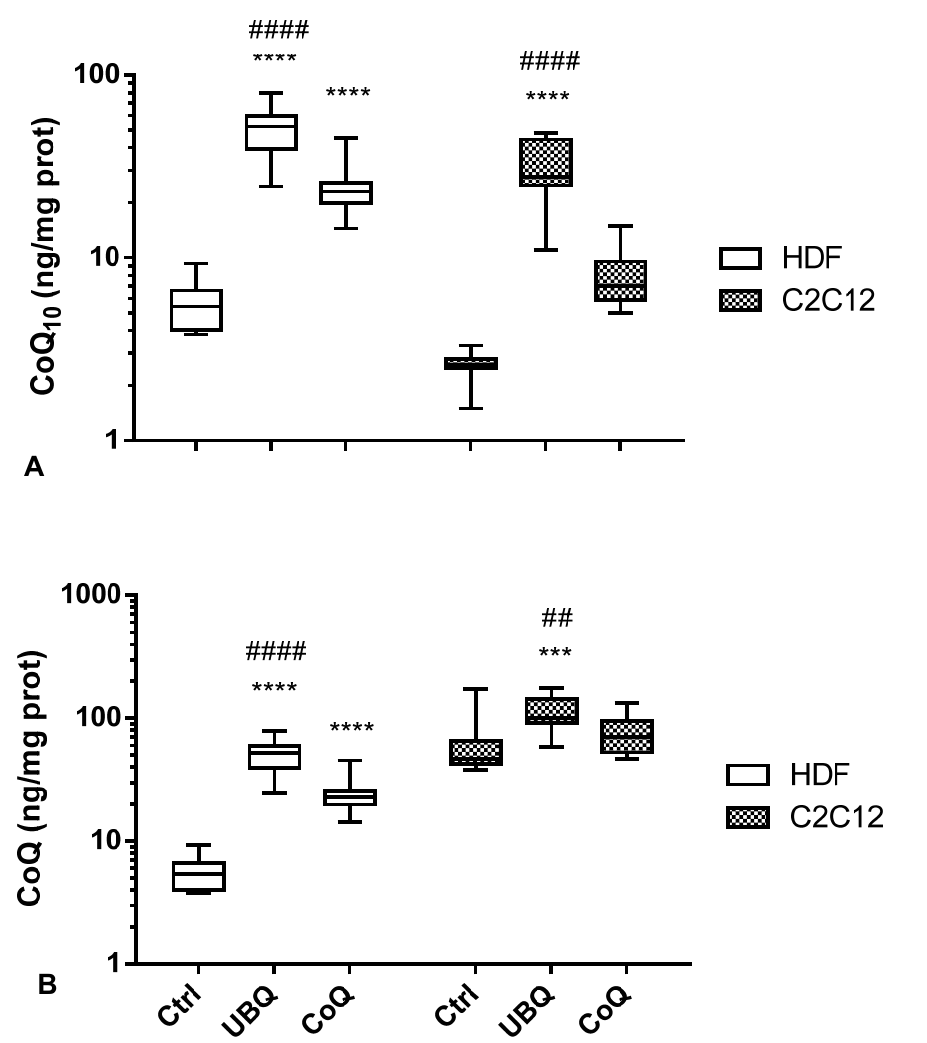
Figure 4. Cellular CoQ 10 ( A ) and total CoQ levels ( B ) in human dermal fibroblasts (white clear box plots) and murine skeletal myoblasts (small dot box plots) treated with p medium (controls, Ctrl), enriched LDL derived from the plasma of volunteers supplemented with Ubiqsome (UBQ) or crystalline CoQ 10 (CoQ) at the same concentration of CoQ 10 0.5 µ g/mL for 24 h. Data are expressed as boxes and bar plots (mean value) ( n = 3). Statistical significance was calculated using two-way Anova with Tukey’s multiple comparisons tests compared with the control cells (Ctrl) (*** p < 0.001, **** p < 0.0001) or crystalline CoQ 10 (CoQ) (## p < 0.01, #### p <